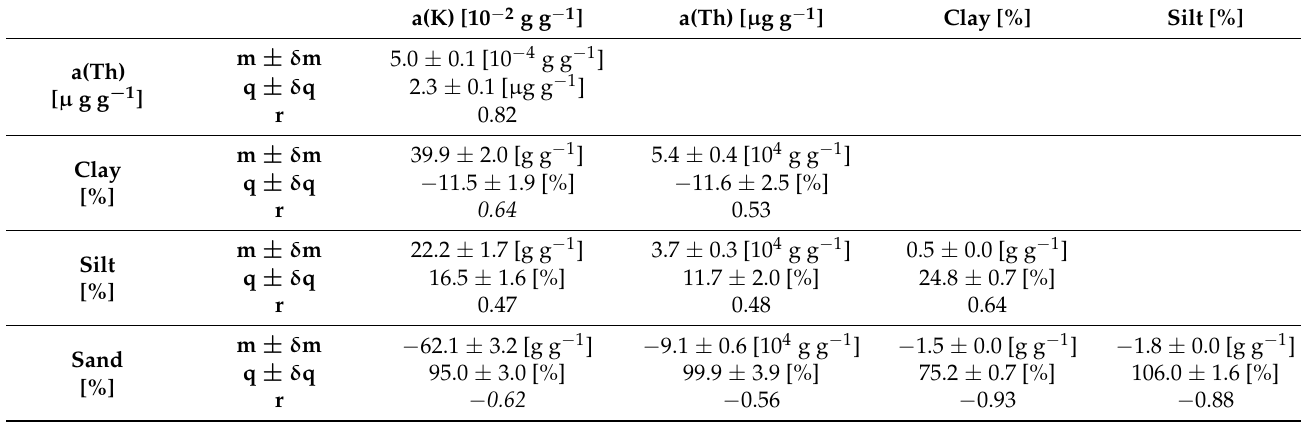
Table 1. Results of the SLR analysis between textural fractions (clay, silt and sand) and radioele- ments abundances (a(K) and a(Th)) performed on the training dataset (N = 578). The parameters (m and q) of the SLR model are reported together with their standard deviations ( δ m and δ q) (cid:115)(cid:18) (cid:115) (cid:19) (cid:19) (cid:18) 2 ( Y ) 2 ( Y ) 2 ˆY ˆY ∑ N ∑ N 1 i − i i − i i = 1 i = 1 + a ( X ) · ( δ m = , where N is the (cid:105) , δ q = (cid:104) N − 2 N ( a ( X ) ∑ N − a ( X ) ) 2 − a ( X ) ) 2 ( N − 2 ) · ∑ N i = 1 ( a ( X ) i = 1 i i total number of data, Y i is the i-th soil texture fraction value provided by RER, ˆY i is the i-th predicted soil texture fraction value, a ( X ) is the i-th measured abundance of radioelement X and a ( X ) is the i mean value of the a ( X ) ) and the Pearson correlation coefficient (r); the highest r values for relations i between soil fraction and radioelement abundance are shown in italic. a(K) [10 − 2 g g − 1